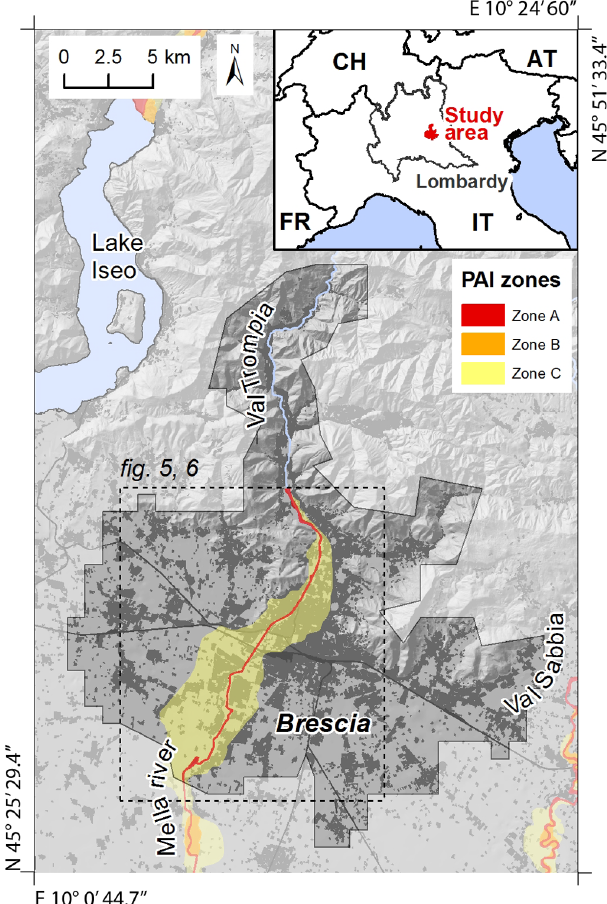
Fig. 1. Risk hot spot area (in black) as obtained from multi-risk analysis at the regional scale (Lari et al., 2009). Flooding zones as defined by the basin-scale regulatory map zonation (PAI – Piano stralcio di Assetto Idrogeologico, 2007). Three flooding areas are identified: zone A is defined as the area which contains 80% of the discharge for a 200-yr flood; zone B is defined as the flooding area for a 200yr flood; zone C is defined as the flooding area for a 500-yr